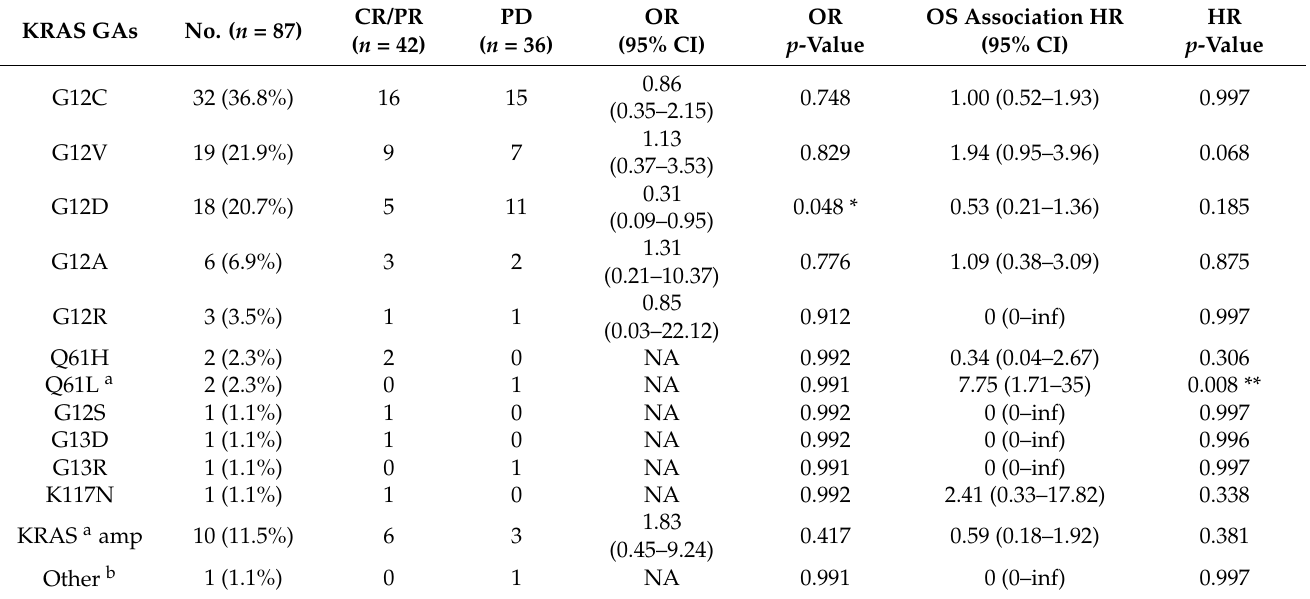
Figure 1. KRAS mutation subtype characteristics by response ( n = 87). Table 2. KRAS mutation subtypes with responses and OS ( n =